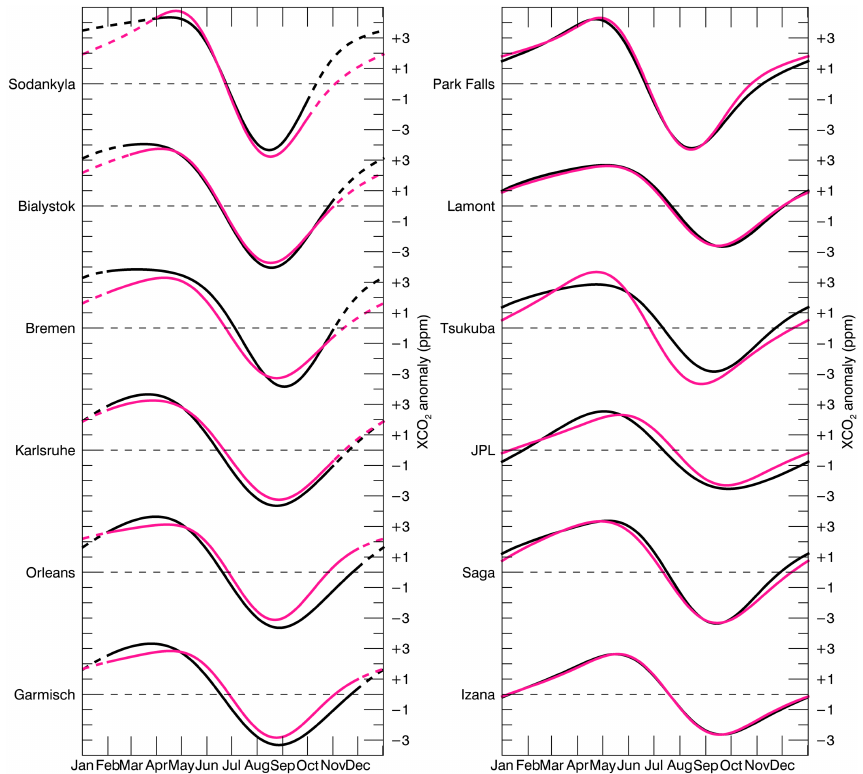
Figure 4. Detrended, best-fit seasonal cycles for GOSAT/ACOS (pink) and TCCON (black) at 12 validation sites in the Northern Hemisphere. The sites are organized according to their latitude (Sodankylä highest, Izaña lowest). The dashed lines depict the times of year with no or few co-located soundings. On the vertical axis, one tick interval corresponds to 1.0ppm XCO 2